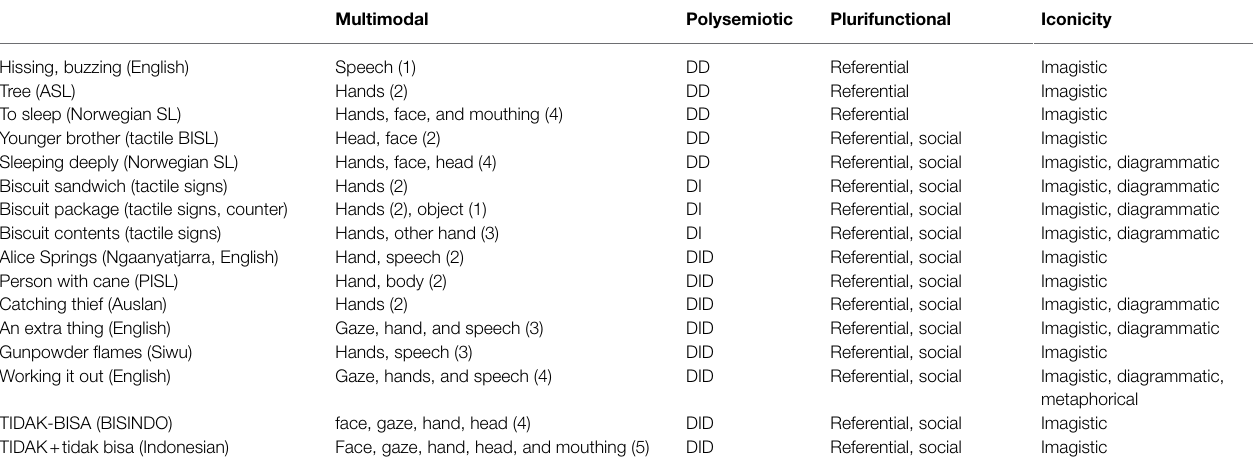
TABLE 1 | Iconicity as multimodal, polysemiotic, and plurifunctional (number of articulators in parentheses and note this summary is not necessarily exhaustive). Multimodal